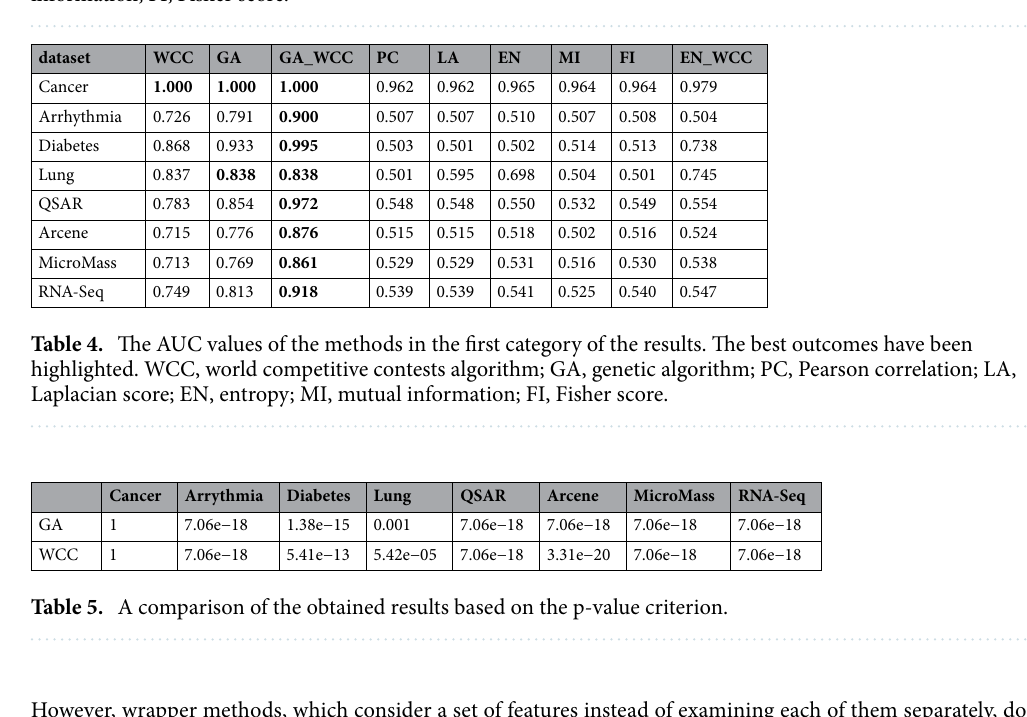
Figure 11. ROC curves of the methods on the second category of datasets (high dimensional). ( a ) The ROC curve of the manners on the QSAR dataset. ( b ) The ROC curve of the methods on the Arcene dataset. ( c ) The ROC curve of the methods on the MicroMass dataset. ( d ) The ROC curve of the manners on the RNA-Seq dataset. Like Fig. 10, these diagrams state that optimization algorithm can acquire better results than other algorithms, and two-step feature selection method may be a suitable technique for choosing the most effective features or genes in the biology field. ROC, receiving operating characteristic; WCC, world competitive contests algorithm; GA, genetic algorithm; PC, Pearson correlation; LA, Laplacian score; EN, entropy; MI, mutual information; FI, Fisher score.